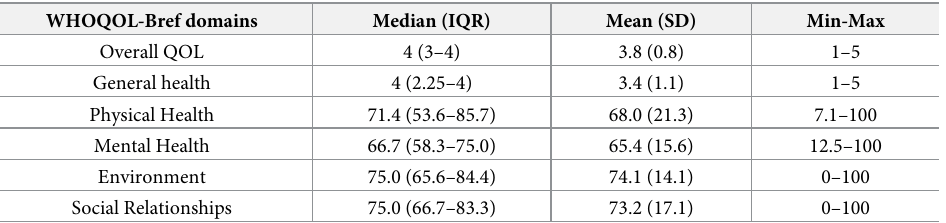
Table 2. CABM participants’ WHOQOL-Bref scores at 12 months from